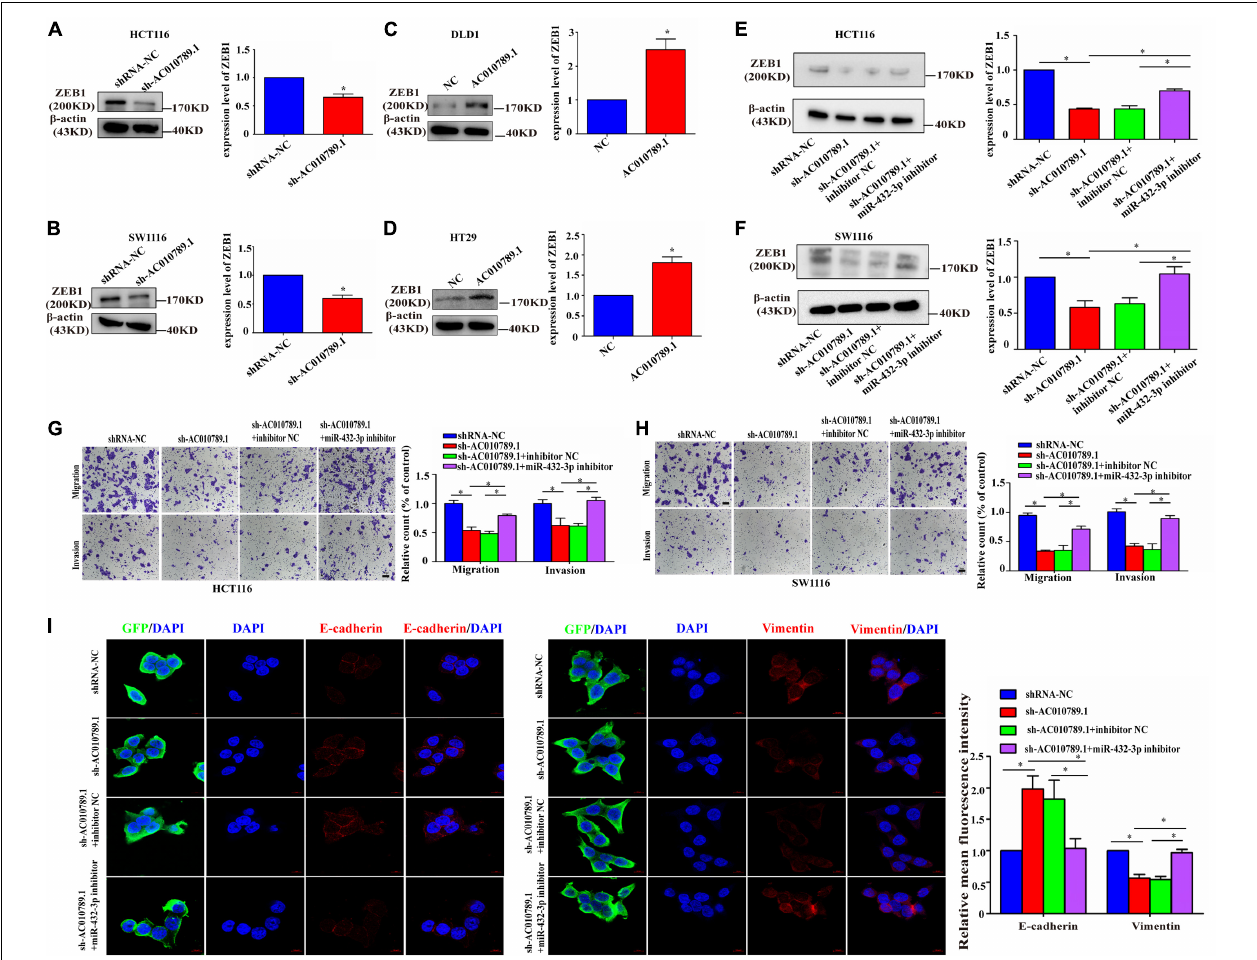
FIGURE 6 | AC010789.1 promotes migration, invasion and EMT through miR-432-3p/ZEB1 axis. (A,B) The protein level of ZEB1 in HCT116 and SW1116 cells with AC010789.1 stable knockdown. (C,D) The protein level of ZEB1 in DLD1 and HT29 cells with AC010789.1 overexpression. (E,F) Expression level of ZEB1 was determined by western blot after transfection with shRNA-NC, sh-AC010789.1, sh-AC010789.1 + inhibitor NC, sh-AC010789.1 + miR-432-3p inhibitor in HCT116 and SW1116 cell. (G,H) Transwell assay for investigating migration and invasion change after transfection with shRNA-NC, sh-AC010789.1, sh-AC010789.1 + inhibitor NC, sh-AC010789.1 + miR-432-3p inhibitor in HCT116 and SW1116 cells, Scale bar: 100 µ m. (I) The expression of E-cadherin (red), vimentin (red), and GFP (green) in HCT116 cells treated with shRNA-NC, sh-AC010789.1, sh-AC010789.1 + inhibitor NC, sh-AC010789.1 + miR-432-3p inhibitor were detected by immunofluorescence. Cells nuclei were stained with DAPI (blue). Error bars:10 µ m. Data are representative of three independent experiments and are presented as mean ± SEM. P -values were determined by two-tailed student’s t -test or one-way ANOVA (* P <